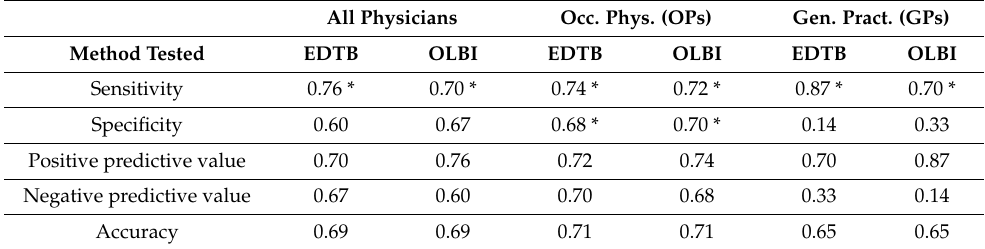
Table 9. Comparison between the EDTB and the OLBI among OPs and GPs. All